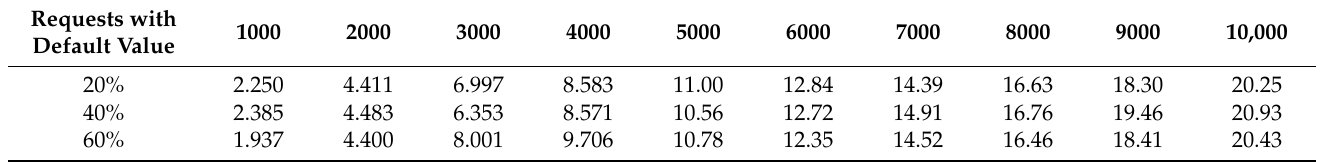
Figure 10. Evaluation performance of modified policy set.